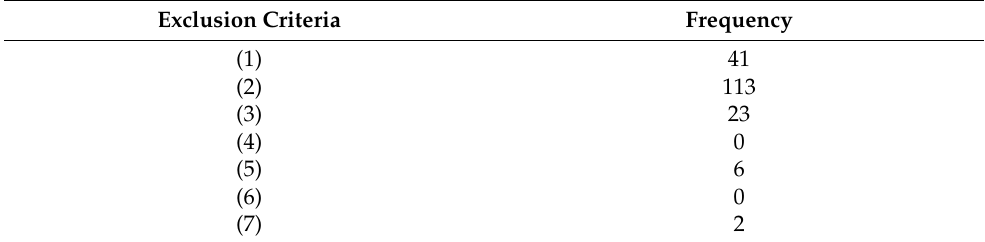
Table 7. Reason for paper exclusion.